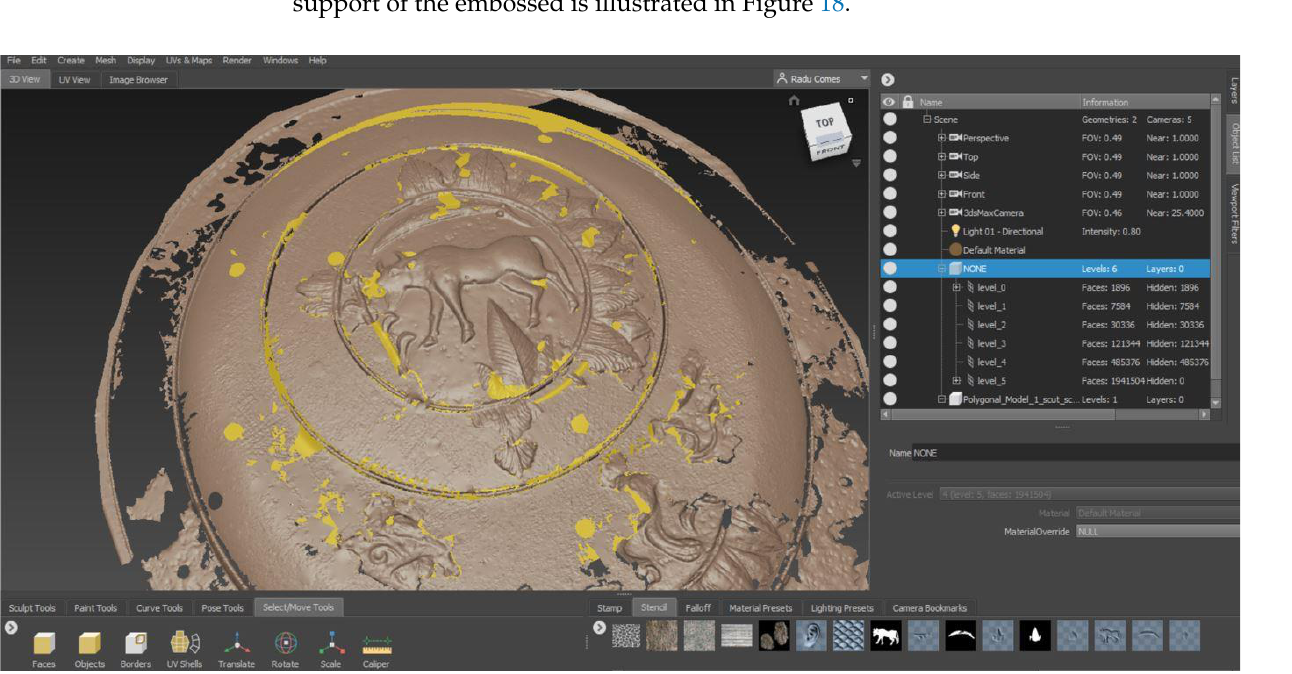
Figure 18. The two 3D models (reference and reconstructed surface) within Mudbox.